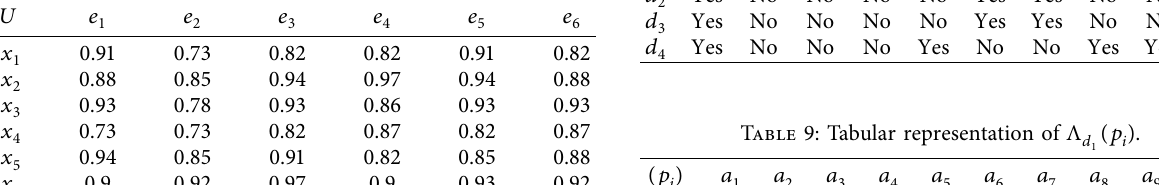
Table 4: Tabular representation of ( H